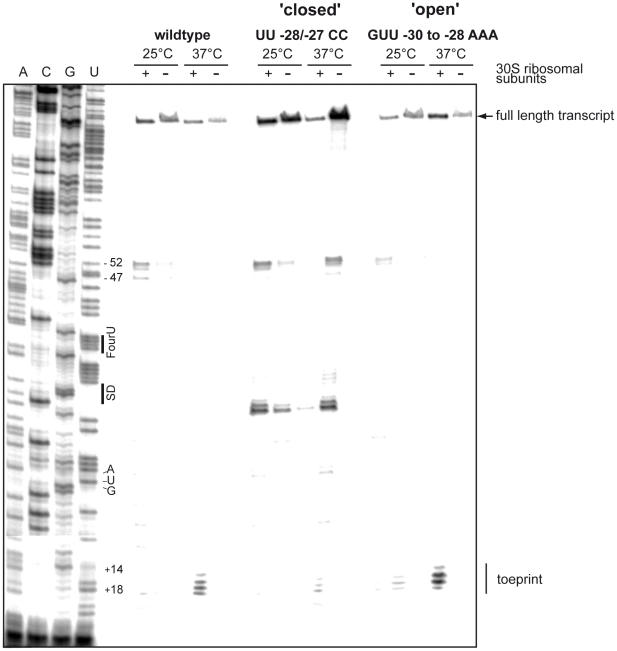
Temperature-dependent binding of ribosomes to the yscW-lcrF intergenic region.Toeprinting analysis was performed with the wildtype, the repressed (UU-28/-27CC) and derepressed (GUU-30/-28AAA) variants as described in material and methods. The presence (+) and absence (−) of the 30S ribosomal subunits are indicated. The terminated primer extension products (toeprints) are marked. The sequencing ladder (ACGU) generated with the same lcrF-specific primer is loaded on the left. The positions of the fourU motif, the Shine-Dalgarno sequence and the start codon AUG are indicated.